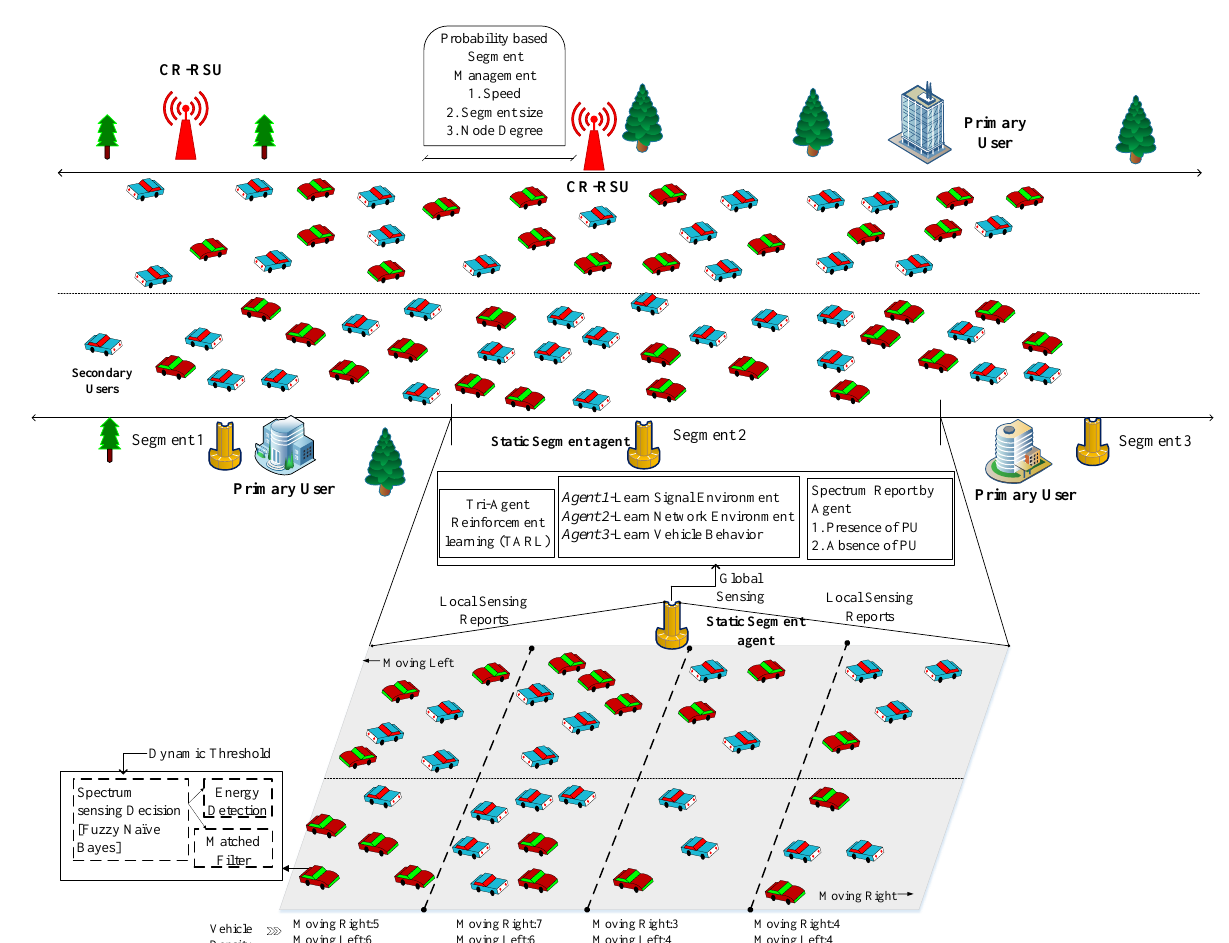
Figure 1. Proposed segmented cognitive radio vehicle ad hoc network (CR-VANET) model.